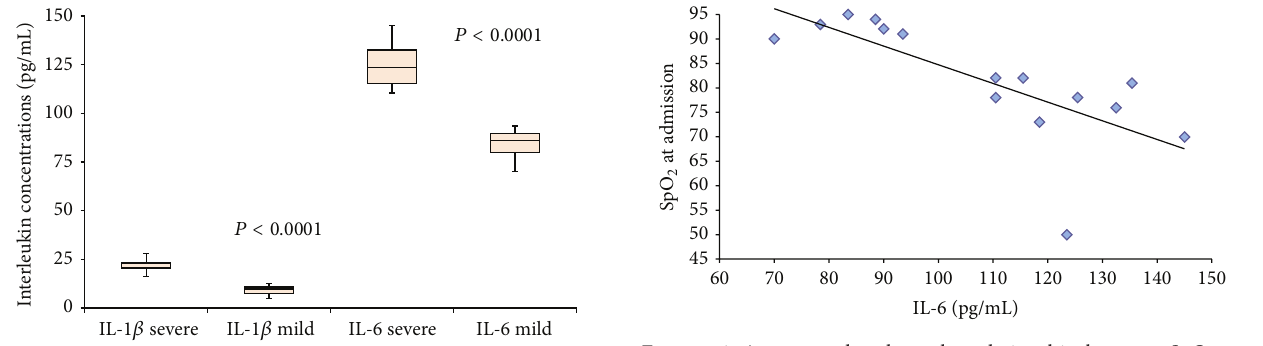
Figure 6: A scatter plot show the relationship between SpO 2 at admission in room air and IL-6 plasma level. The line represents the regression line (linear regression equation: SpO 2 = −0.38 × IL- 6 + 122.9 𝑅 2 = 0.53